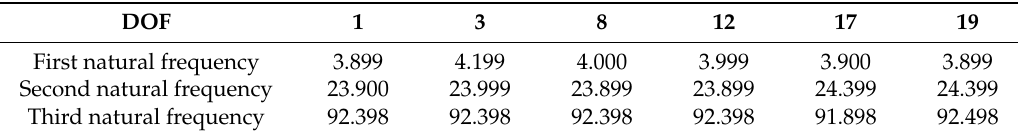
Table 4. First three theoretical frequencies when six virtual masses are added to the undamaged finite element model/Hz.